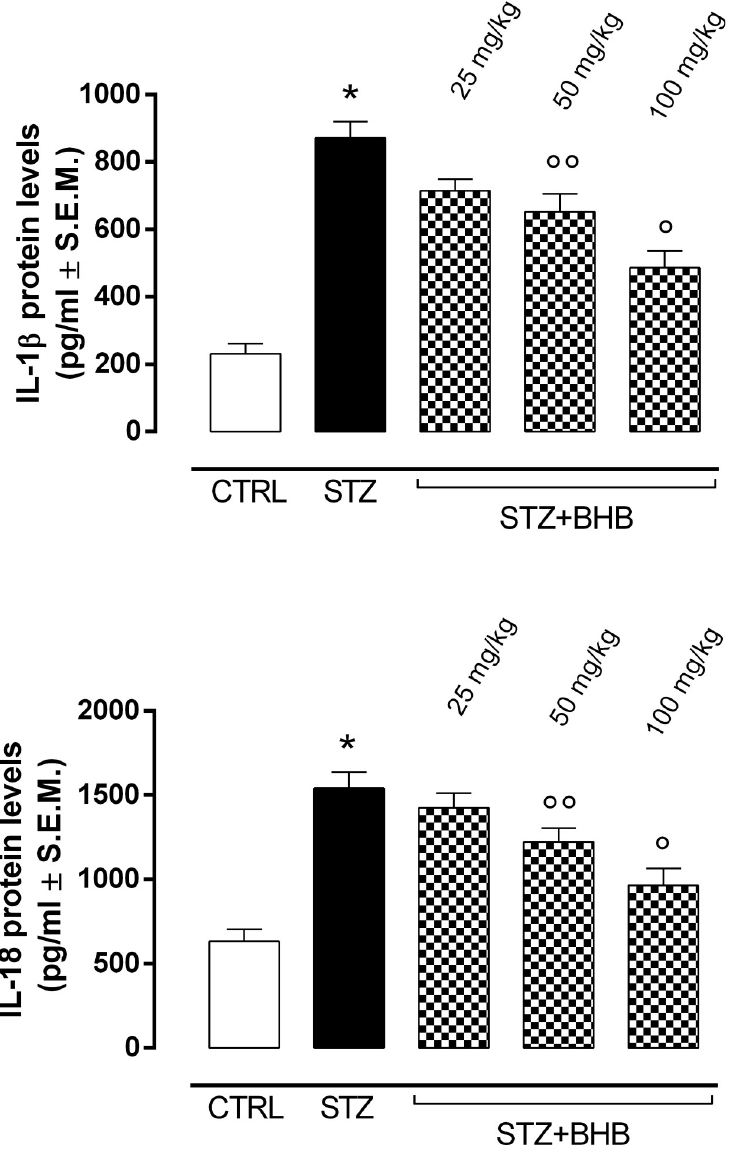
Fig 5. Proinflammatory cytokines IL-1 β and IL-18 levels. Determination of IL-1 β and IL-18 levels by ELISA. Values are expressed as the mean of 10 observations ± S.E.M. CTRL = nondiabetic mice; STZ = diabetic mice; STZ +BHB = diabetic mice receiving BHB. � P < 0.01 vs CTRL; ˚˚P < 0.05 vs STZ; ˚P < 0.01 vs STZ.